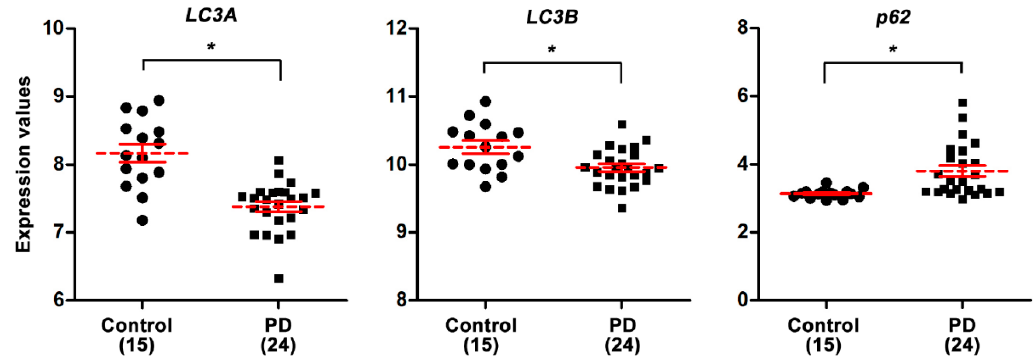
Figure 1. Lowered autophagic activity in the substantia nigra of the midbrain in patients with Parkinson’s disease (PD). Gene expression data (GSE8397) from 24 patients with sporadic PD (15 medial and 9 lateral substantia nigra samples) and 15 normal healthy control (8 medial and 7 lateral substantia nigra samples) were obtained from the National Center for Biotechnology Information (NCBI) Gene Expression Omnibus (GEO) repository. Dot plots with mean + SEM for LC3A , LC3B , and p62 mRNA expressions were created from the gene expression datasets. The analysis reveals decreased LC3A and LC3B mRNA expressions, and increased p62 mRNA expression, in PD as compared to controls. Comparisons of mean + SEM between the control and PD groups were analyzed using the Partek Genomics Suite software. Statistical significance of between-group differences was analyzed using the Mann–Whitney U test. * p < 0.05.